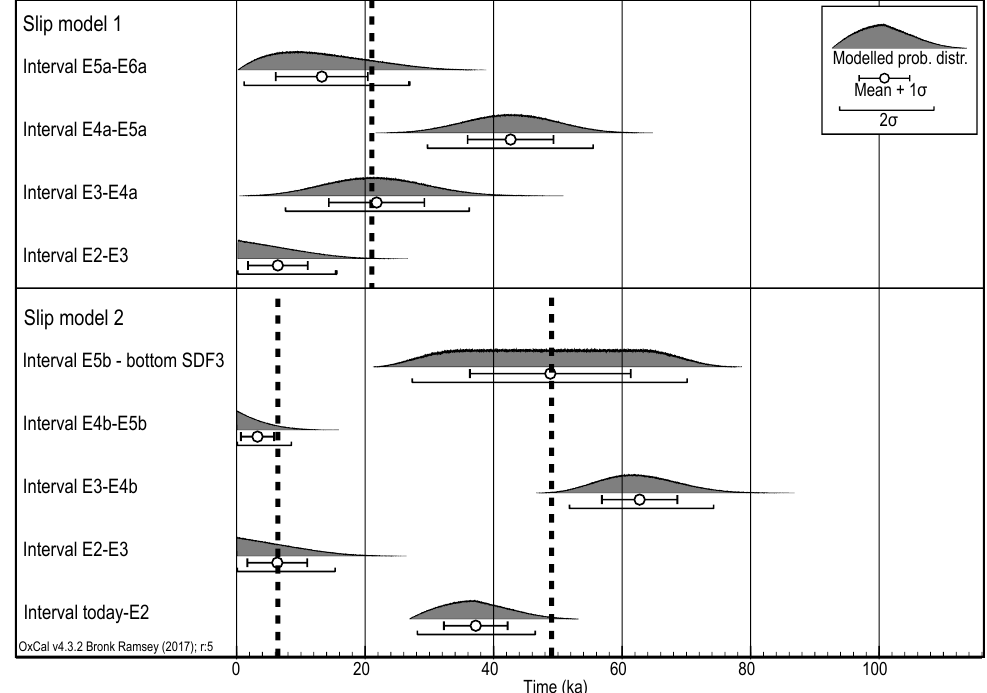
Figure 12. Recurrence intervals for slip model 1 (upper panel) and slip model 2 (lower panel),